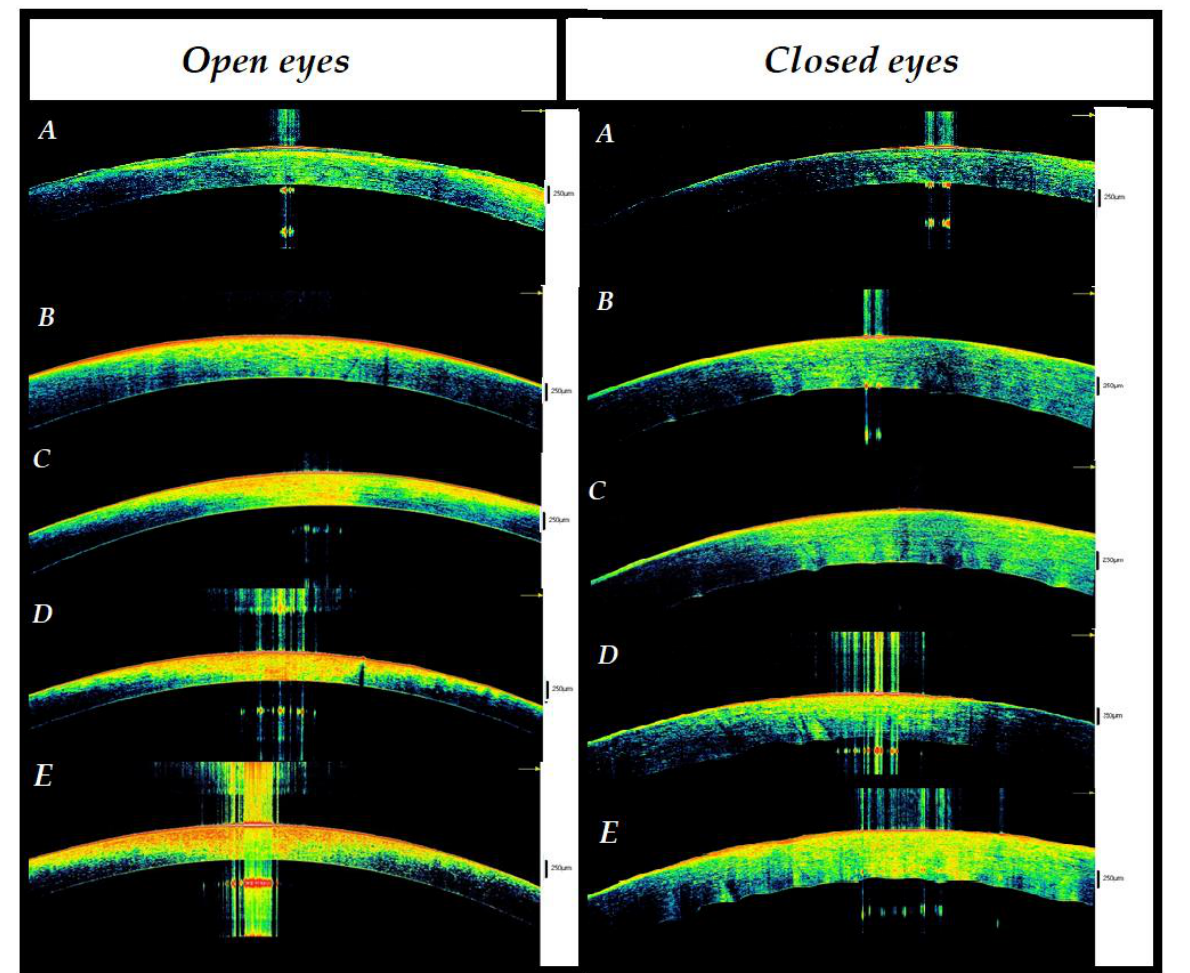
Figure 6. Comparison of changes over time between closed and open eyes. ( A ) Baseline. It includes the interval between death and the third hour without any change in the state of opening of the eyelids. The structure of the corneas appeared normal, similar to that of living people. Of interest, stromal striae (SS) are easily detected in a number of cases. ( B ) Interval between the third and sixth hour. The comparison showed the appearance of hyper-reflectivity in the anterior cornea in the open eye. At the level of the epithelium, the presence of the ‘binary sign’ was recorded in all cases. In closed eyes, on the other hand, a stromal thickening with initial waving of the posterior part of the cornea was observed. ( C ) In the open eyes there was, at the epithelial level, the presence of a single hyper-reflective layer that replaced the binary sign. The stroma was thinned and characterized by hyper-reflectivity in its anterior 3/4. In closed eyes, a thickening of the stroma with the presence of single peak that protruded posteriorly into the anterior chamber was recorded. ( D ) Interval between the ninth and twelfth hour. In the open eyes, further thinning of the stroma was observed with full thickness hyper-reflectivity in the central part. In closed eyes, a stromal thickening with differenti- ation between the anterior (hyper-reflective) and posterior (hyporeflective) portions was recorded and the presence of at least two peaks protruding in the posterior part was noted. ( E ) Interval be- tween the twelfth and fifteenth hour. In open eyes, the initial presence of hyporeflectivity in the posterior stroma and the appearance of endothelial hyporeflectivity spots was observed. On the other hand, in closed eyes, a further important increase in stromal thickness was revealed with the presence of hyper-reflective spots in the tissue. Moreover, the presence of more protruding peaks in the posterior chamber was noted. With regard to the remaining signs, see Table I and Table II for details.